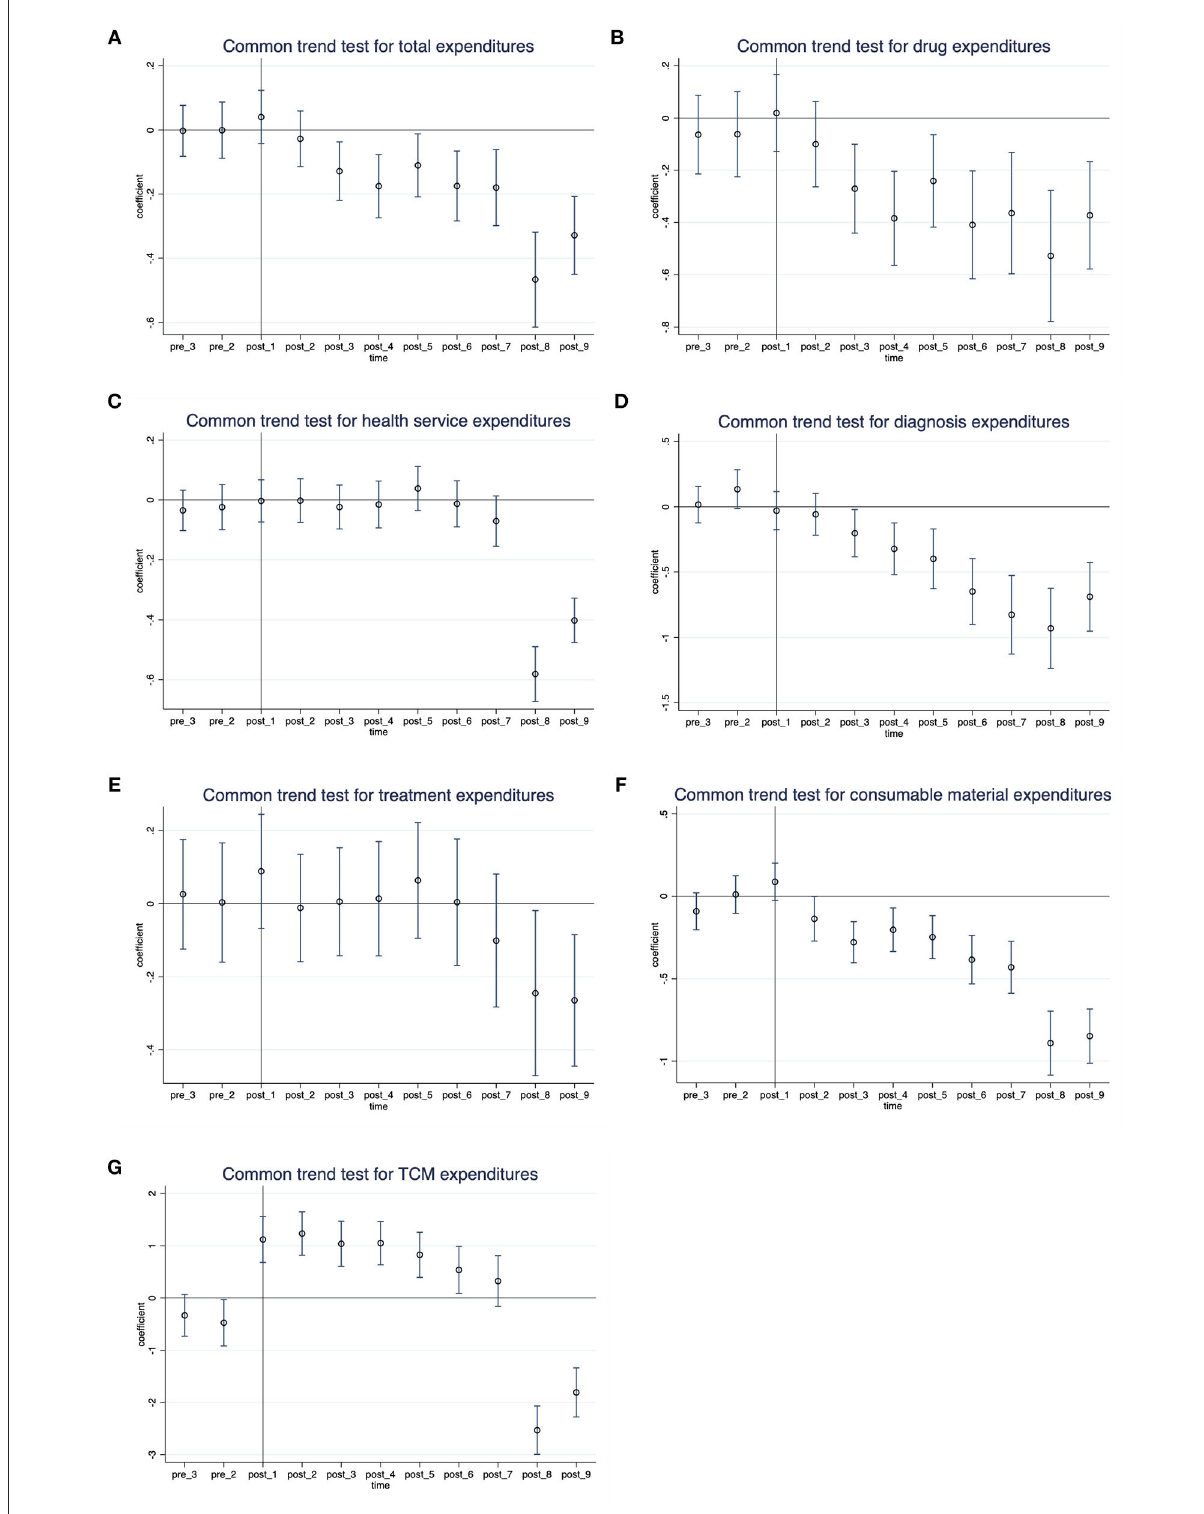
FIGURE2 Common trends test for DID: Monthly differences between the treatment group and control group. (A) Total expenditures, (B) drug expenditures, (C) health service expenditures, (D) diagnosis expenditures, (E) treatment expenditures, (F) consumable material expenditures, and (G) TCM